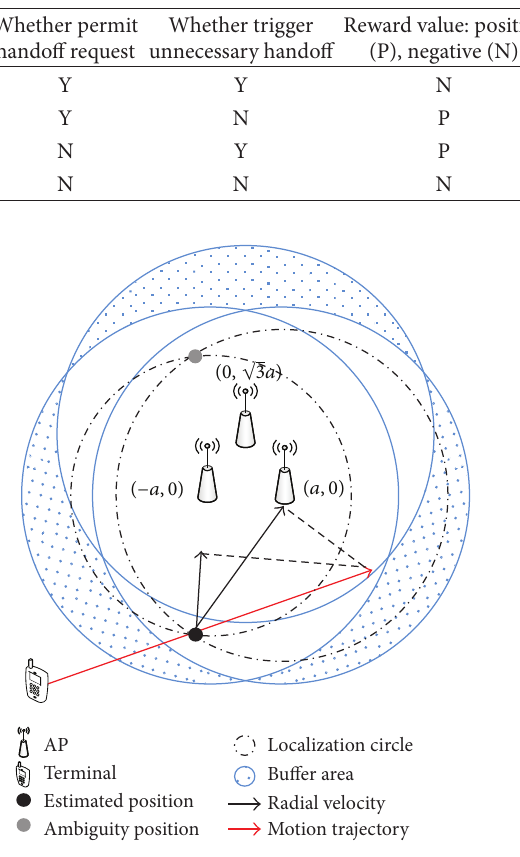
Figure 2: An outdoor AP deployment